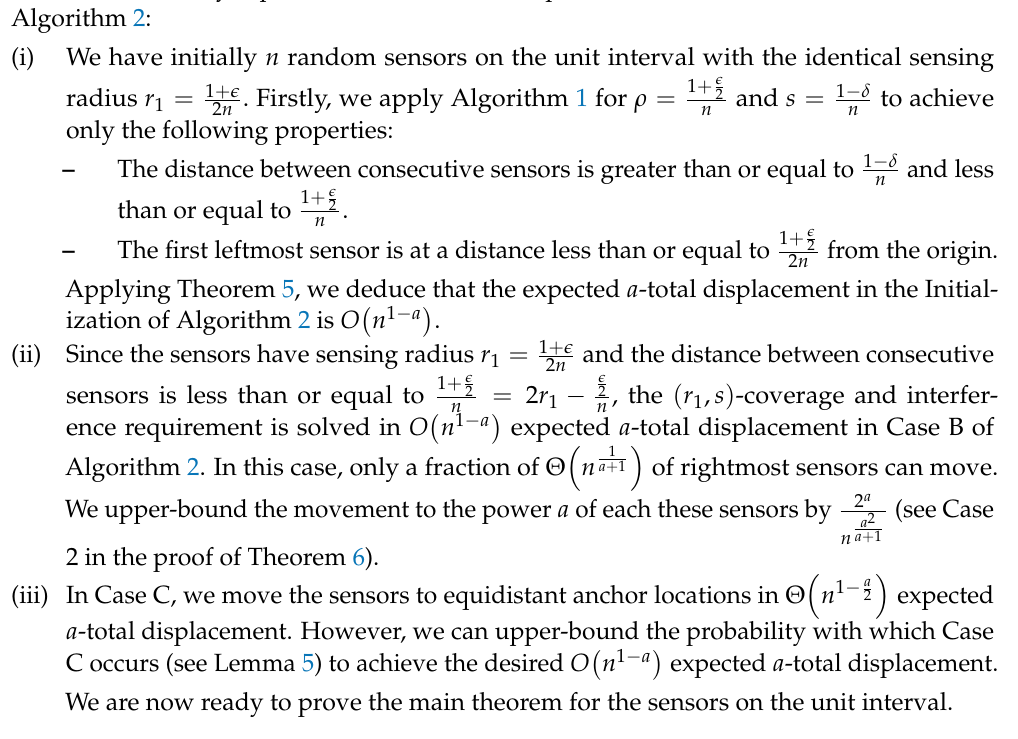
Algorithm 2. In this case, only a fraction of Θ